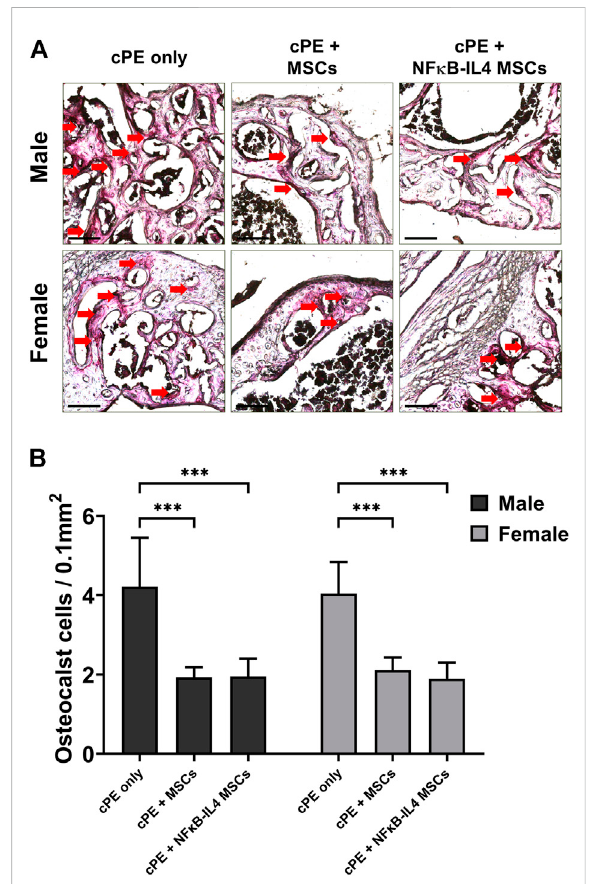
FIGURE 4 TRAP staining analysis of harvested sample at 6 weeks. (A) representative images of TRAP staining, red arrows point out the TRAP positive cells. Scale bar = 100 μ m. (B) quantitative analysis of TRAP positive cells number per area. Osteoclast-like cells were signi fi cantly decreased after MSC-based therapy in both males and females. (Males, cPE only group: n = 7, cPE + MSCs group: n = 8, cPE + NF κ B-IL4 MSCs group: n = 9; Females, cPE only group: n = 5, cPE + MSCs group: n = 7, cPE + NF κ B-IL4 MSCs group: n = 5; *** p < 0.001, Two-way ANOVA compared to sex- matched